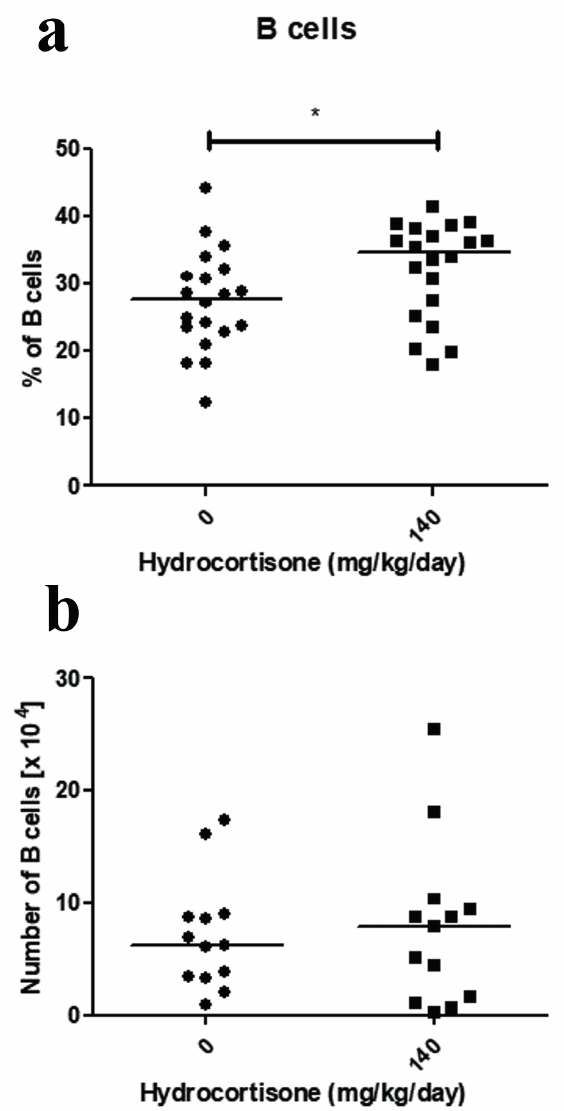
Figure 5 - Effect of in vivo treatment with hydrocortisone on blood B cells. Mice were injected with diluent or hydrocortisone (140 mg/kg/day) for 3 consecutive days. In the next day, blood cells were counted and stained with monoclonal antibody for CD19 molecule for analysis by flow cytometry. ( a ) Percentage and ( b ) the total number of B cells (CD19+). Line represents the median of the data and (*) represents values of p<0.05, according to the statistical test. Results are representative of 3 independent experiments with 3-5 mice/group